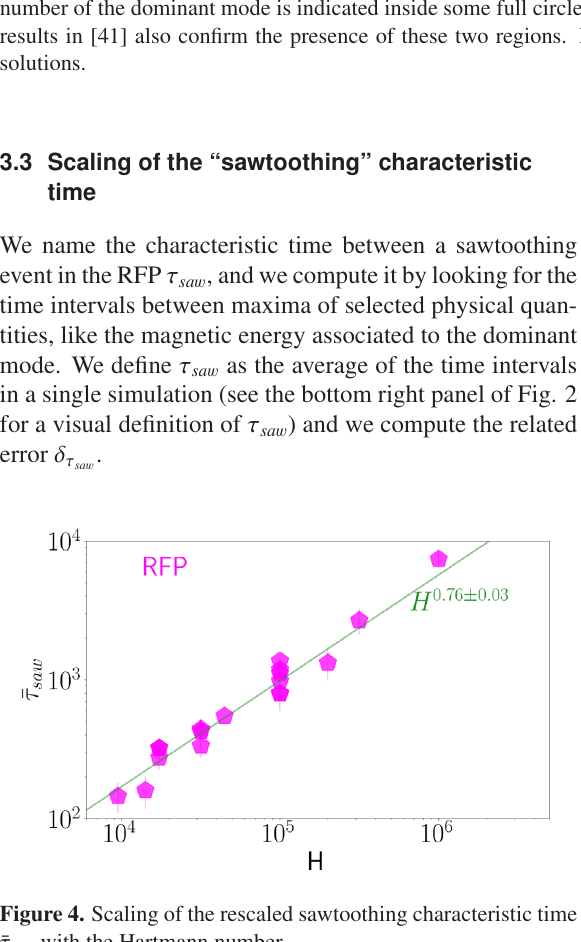
Figure 4. Scaling of the rescaled sawtoothing characteristic time ¯ τ sa w with the Hartmann